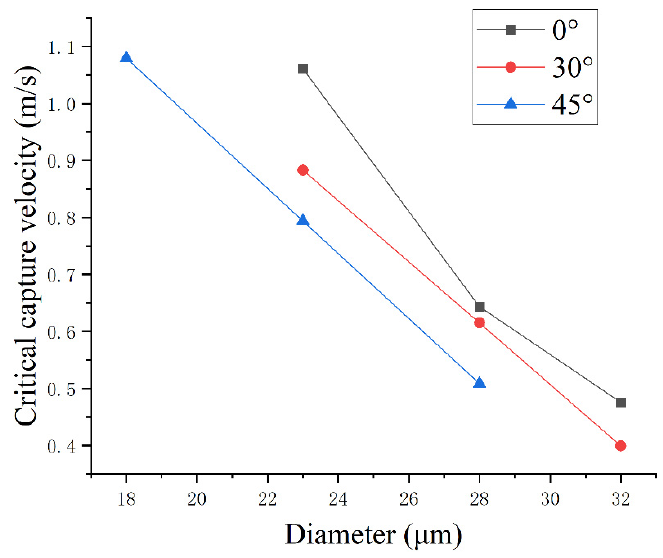
Figure 9. The variation curve of critical capture velocity with particle diameter predicted by BD model under three different incident angles.